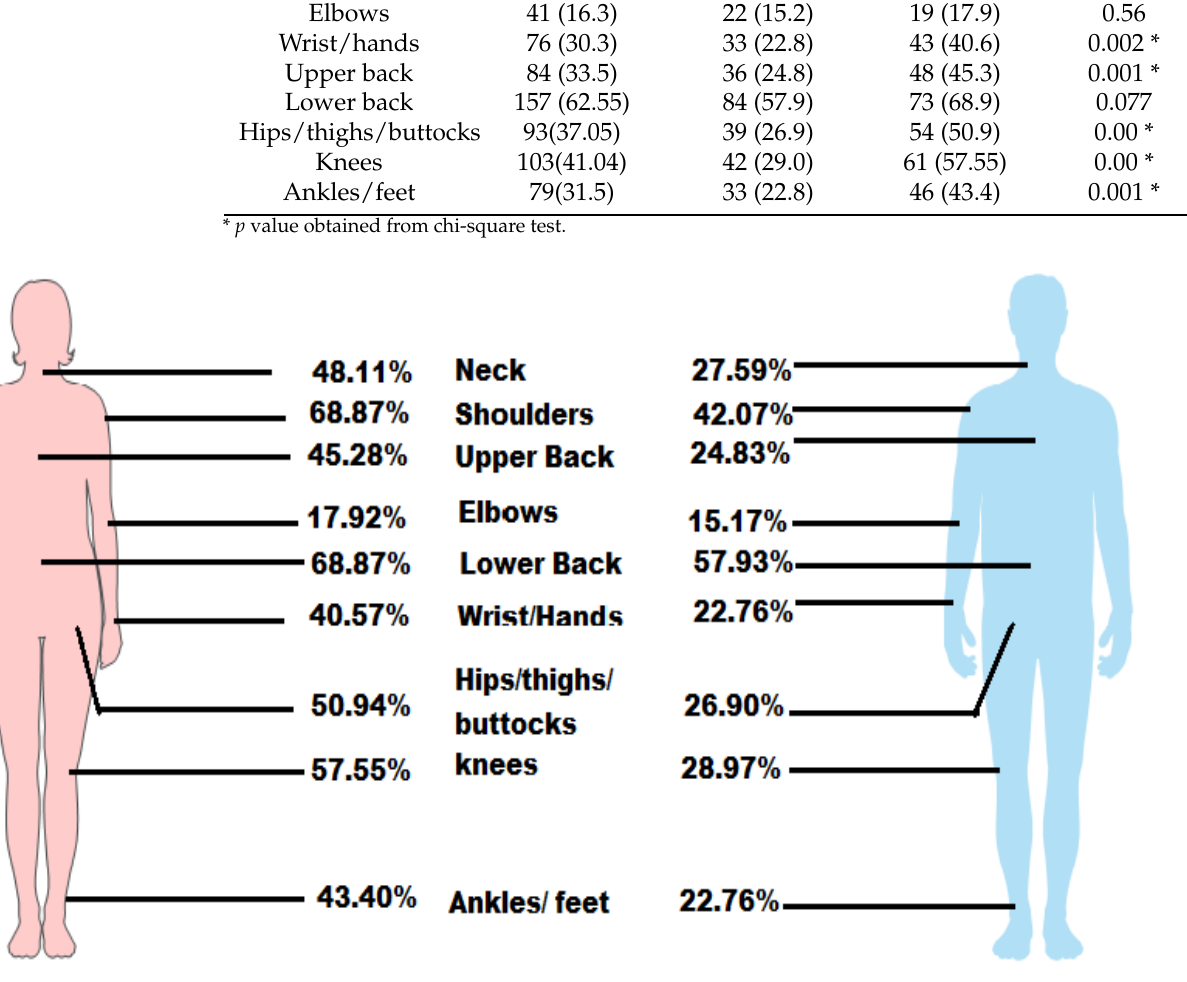
Figure 2. Gender-based distribution of musculoskeletal disorders in teachers. Binomial logistic regression was performed to investigate the effects of age, gender, smoking, sleeping hours per day, experience, working hours per day and lower back, shoulder and knee disorders. The model explained 8.2% (Nagelkerke R2) of variations in lower back pain and correctly classified 66.5% of the cases. Of the seven variables included, only smoking was statistically significant “Odds ratio (OR): 2.64 (Confidence Intervals 95% (95% CI): 1.36–5.13; p = 0.004)”. Smokers had a 2.64-fold higher odds ratio than nonsmokers (Table 4). In the shoulder region, the model explained 11.6% (Nagelkerke R2) of variations in shoulder pain and correctly classified 65.3% of the cases. Gender was statistically significant “OR: 2.697 (95% CI: 1.524–4.776; p value = 0.001)”. Females had a 2.697-fold higher odds ratio than males (Table 5). In the knee region, the model explained 16.1% (Nagelkerke R2) of the variations in knee pain and correctly classified 67.7% of the cases. The association of knee pain with gender and sleeping hours was statistically significant: gender “OR: 3.649 (95% CI: 2.009–6.630; p = 0.000)” and sleeping hours “OR: 0.689 (95% CI: 0.477–0.996; p = 0.048)”. Females had a 3.649-fold higher odds ratio than males (Table 6).